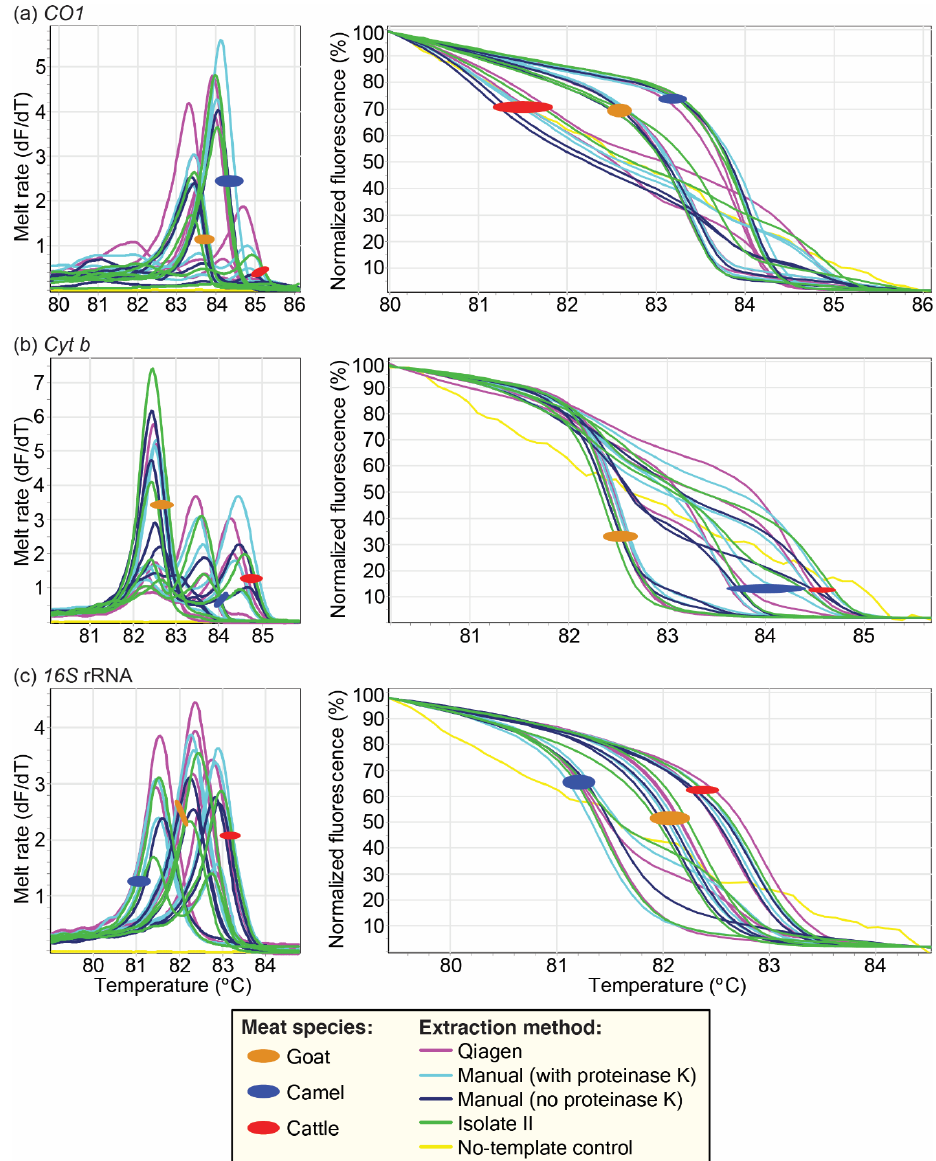
Figure 5. PCR-HRM profiles of representative reference samples whose DNA was extracted using different extraction protocols. DNA was extracted from goat, camel, and cattle meat samples using four different extraction protocols. These protocols included two kits, the DNeasy Blood and Tissue Kit protocol and the ISOLATE II Genomic DNA Extraction Kit, and two manual extraction protocols. Their PCR-HRM profiles were then assessed using CO1 , cyt b , and 16S rRNA. For each marker, the HRM profiles are represented as melt rates and normalized HRM profiles. Melt rates are represented as changes in fluorescence units with increasing temperatures (dF/dT) and HRM profiles are represented as percent fluorescence with increasing temperatures for ( a ) CO1 , ( b ) cyt b , and ( c ) 16S rRNA